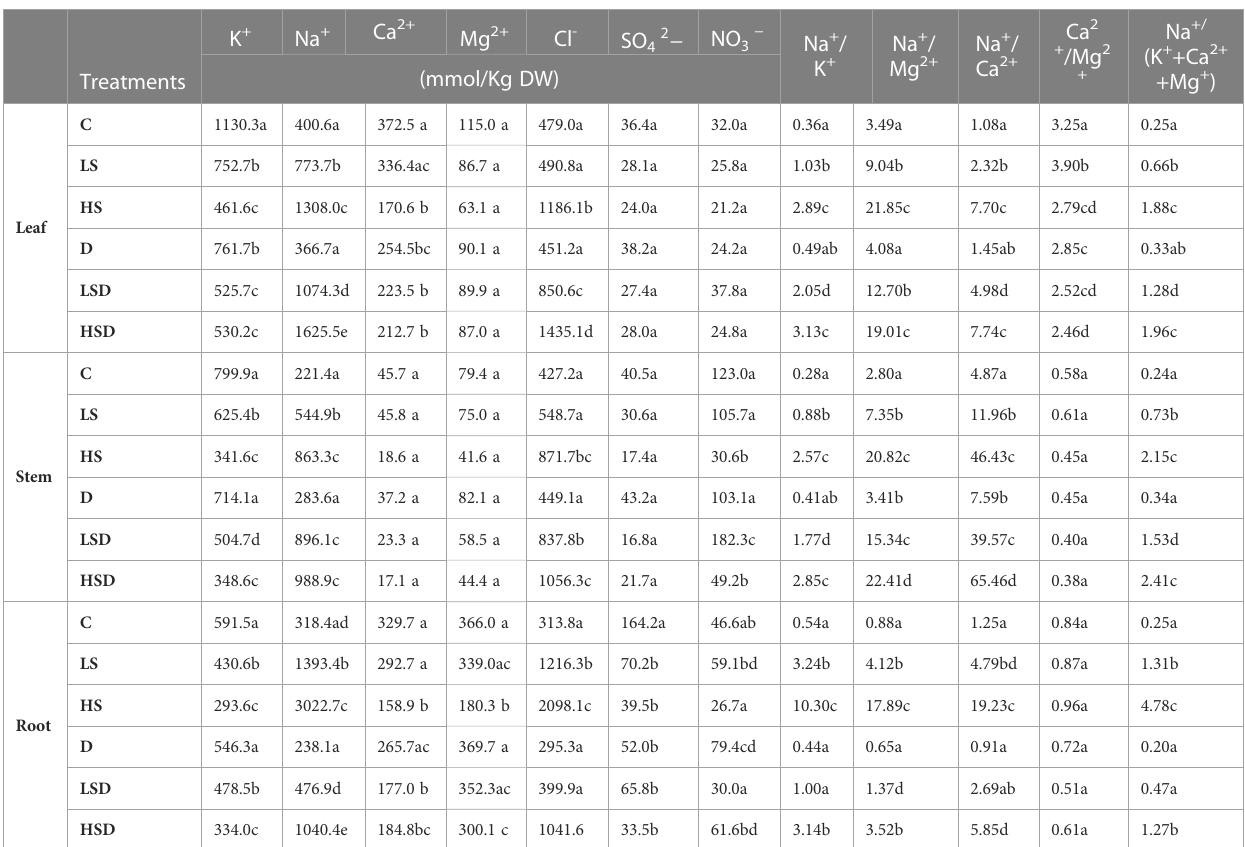
TABLE 1 The effect of salt (0, 100, 300 mM NaCl; abbreviated as C, LS and HS respectively), drought (D) and combination of both (abbreviated as LSD and HSD) on cations (K + , Na + , Ca 2+ and Mg 2+ ), anions (Cl - , SO 42 − and NO 3 − ) and ratios between ions (Na +/ K + , Na +/ Mg 2+ , Na +/ Ca 2+ , Ca 2+/ Mg 2+ and Na + / (K + + Ca 2+ + Mg 2 )) on leaf, stem and root of Panicum antidotale